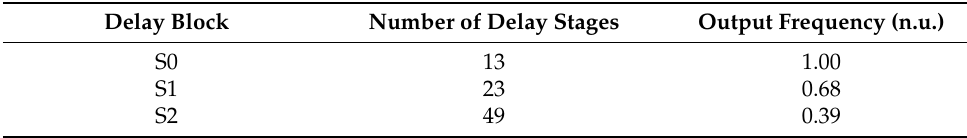
Table 3. NOR-based programmable RO simulation results. Delay